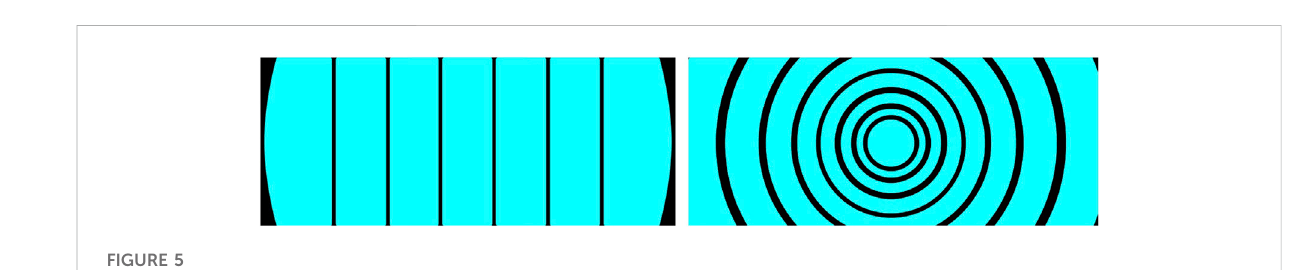
FIGURE 5 eHMI design animated bars as applied for the fi eld